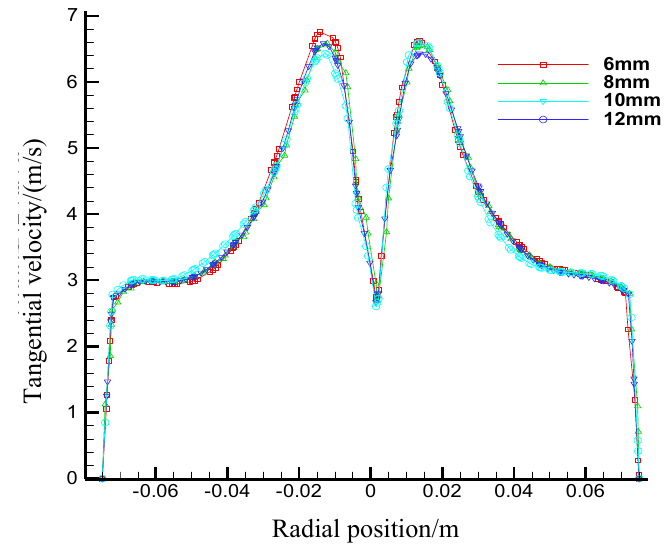
Figure 20. Tangential velocity inside cyclone with different II underflow pipe.